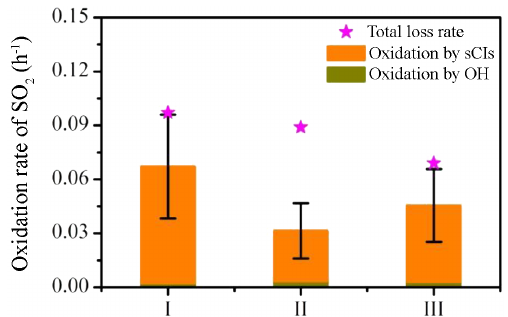
Figure 7. The oxidation rate of SO 2 during the photooxidation of LDGV exhaust with SO 2 . The loss rates of SO 2 reacting with OH radicals and sCIs were calculated by multiplying the reaction rate coefficients derived from the MCM v3.3 by the average OH con- centration and estimated sCIs concentration, respectively. Error bars represent the standard deviation (1 σ ) of the oxidation rate of SO 2 by sCIs throughout the whole